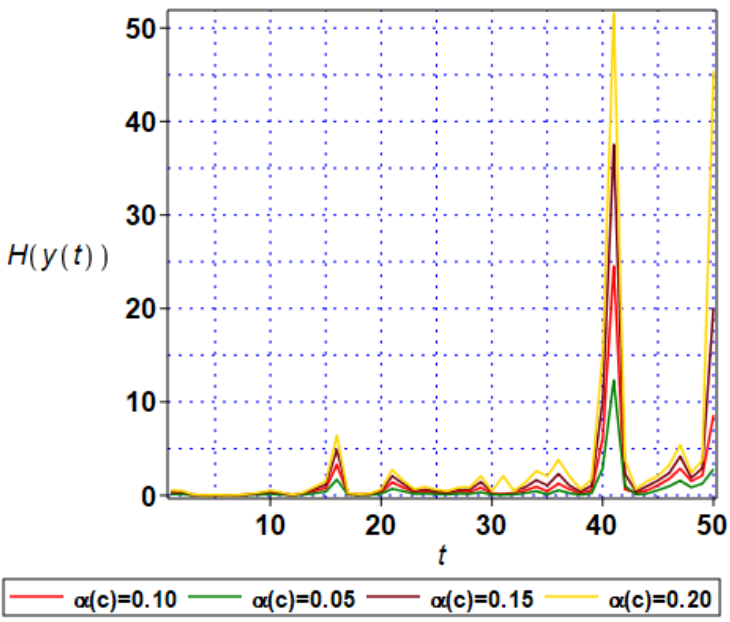
Figure 5. Shannon entropies time fluctuations for Gaussian structural damping.